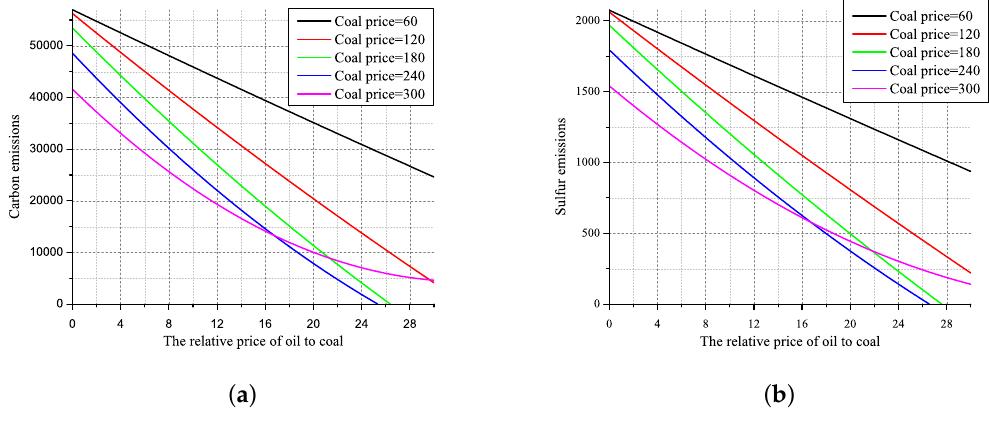
Figure 6. ( a ) Cross-sectional views of W 1 with coal price P 1 between 0–300; ( b ) Cross-sectional views of W 2 with coal price P 1 between 0–300.